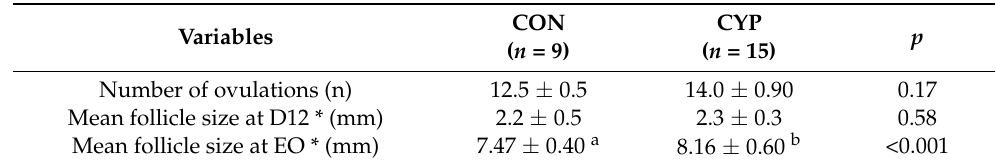
Table 3. Number of ovulations and mean follicle size on day 12 of the estrous cylce (D12) and at estrus onset (EO) of gilts subjected to estrus synchronization protocol using estradiol cypionate and PGF2 α (Mean ±